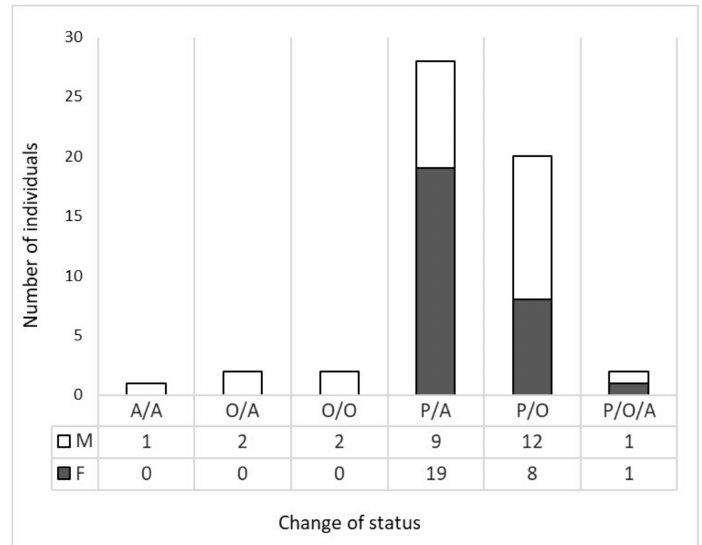
Figure 3. Frequency of changes in social status after dispersal events. By reconstructing the pedigree of each stable pack in the area, each genotype was categorized as a “pup/offspring” (P), or an “alpha/parent” (A), or as “other” (O), if it was not related to any pack, and each frequency of status change was calculated by sex.